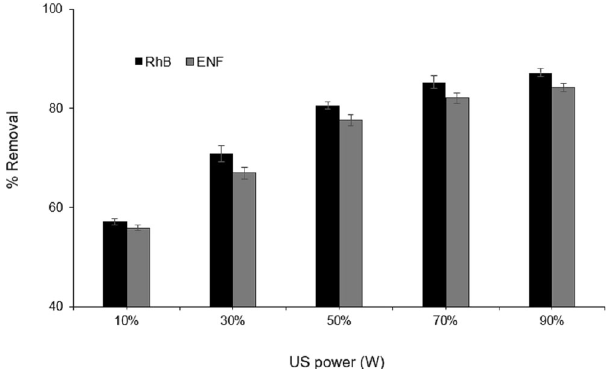
Fig. 3 The effect of ultrasonic power on the removal of ENF and RhB. Removal conditions: adsorbent amount: 0.24 g, RhB concentra- tion: 10 mg L − 1 , ENF concentration: 10 mg L − 1 , sonication time: 23 min, and pH: 7. Error bars represent standard deviations.